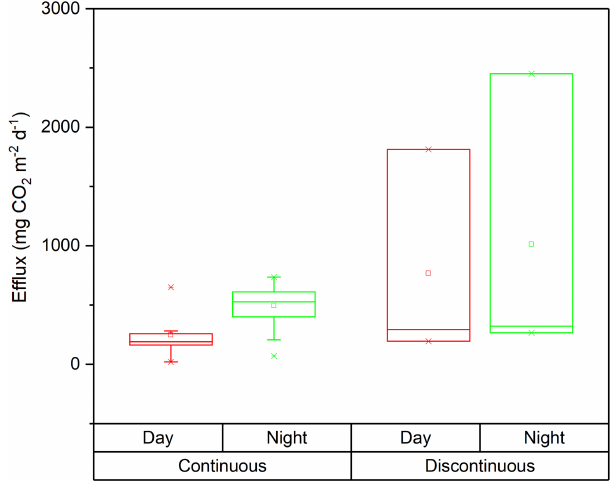
Figure 7. Comparison of effluxes between daytime and night via continuous samples (first two boxes) and discontinuous samples (last two boxes). The lower and upper bounds of the boxes refer to the first and third quartiles, respectively, and the vertical line in- dicates the 1.5 interquartile range. The points outside the range ar considered outliers and are represented by a small cross. Horizontal line refers to the median value while the small squares refer to the average